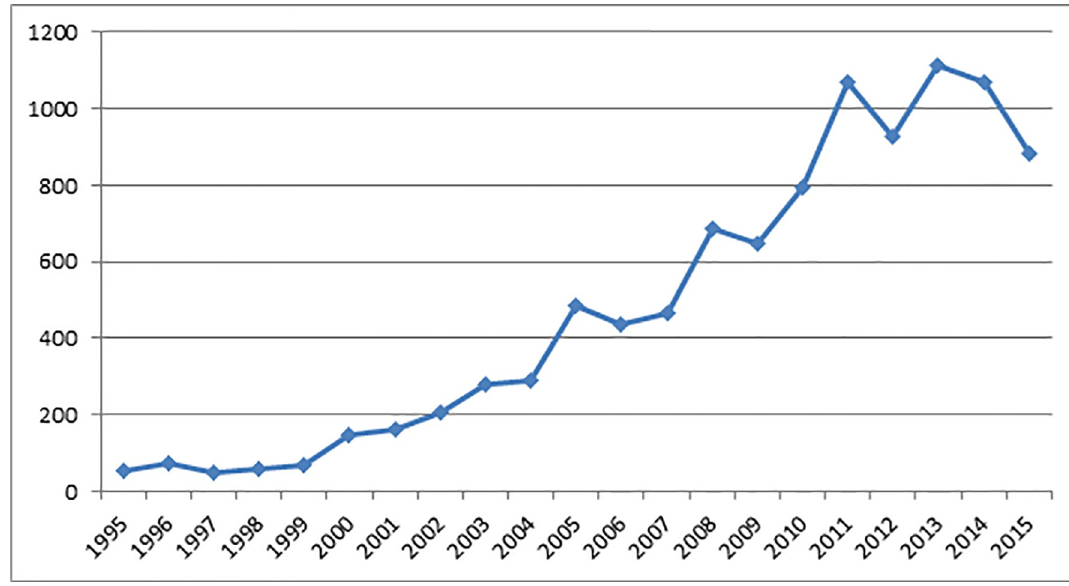
Fig 1. Trend of chemical products’ exports in